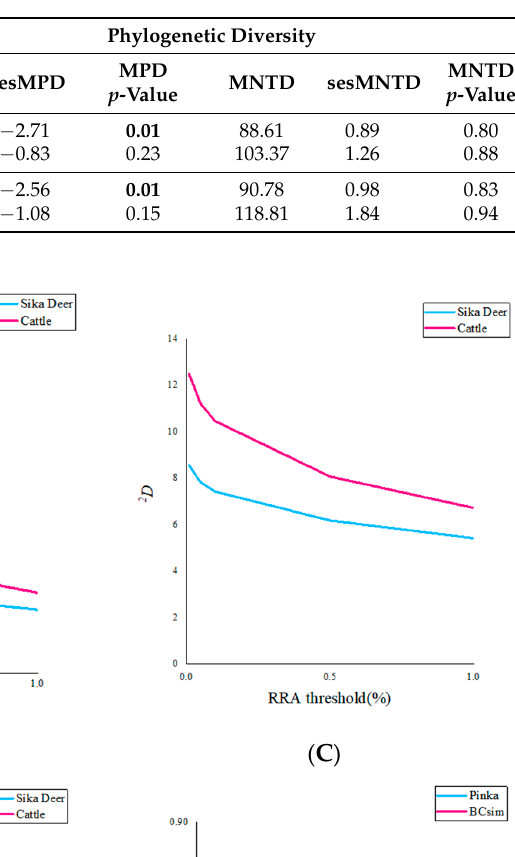
Table 2. Dietary taxonomic diversity is measured by Hill numbers of order number q = 0 ( 0 D ; species richness), q = 1 ( 1 D ; diversity and evenness), and q = 2 ( 2 D ; evenness giving more weight to rare species), and phylogenetic diversity measured by the mean pairwise phylogenetic distance (MPD) and mean nearest taxon distance (MNTD) using the RRA data of prey MOTUs are shown for each carnivore species from the three study areas. Statistically significant ( p < 0.05) of phylogenetic diversity metrics are shown in bold. Two classic metrics for measuring dietary diversity, Levin’s niche breath ( B A ) and Peilou’s evenness ( J ), are also presented.